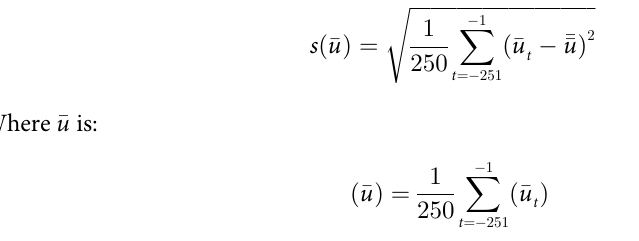
Table 1. Descriptive statistics of abnormal returns in the estimation window. Mean 0.0003 Median Standard Deviation